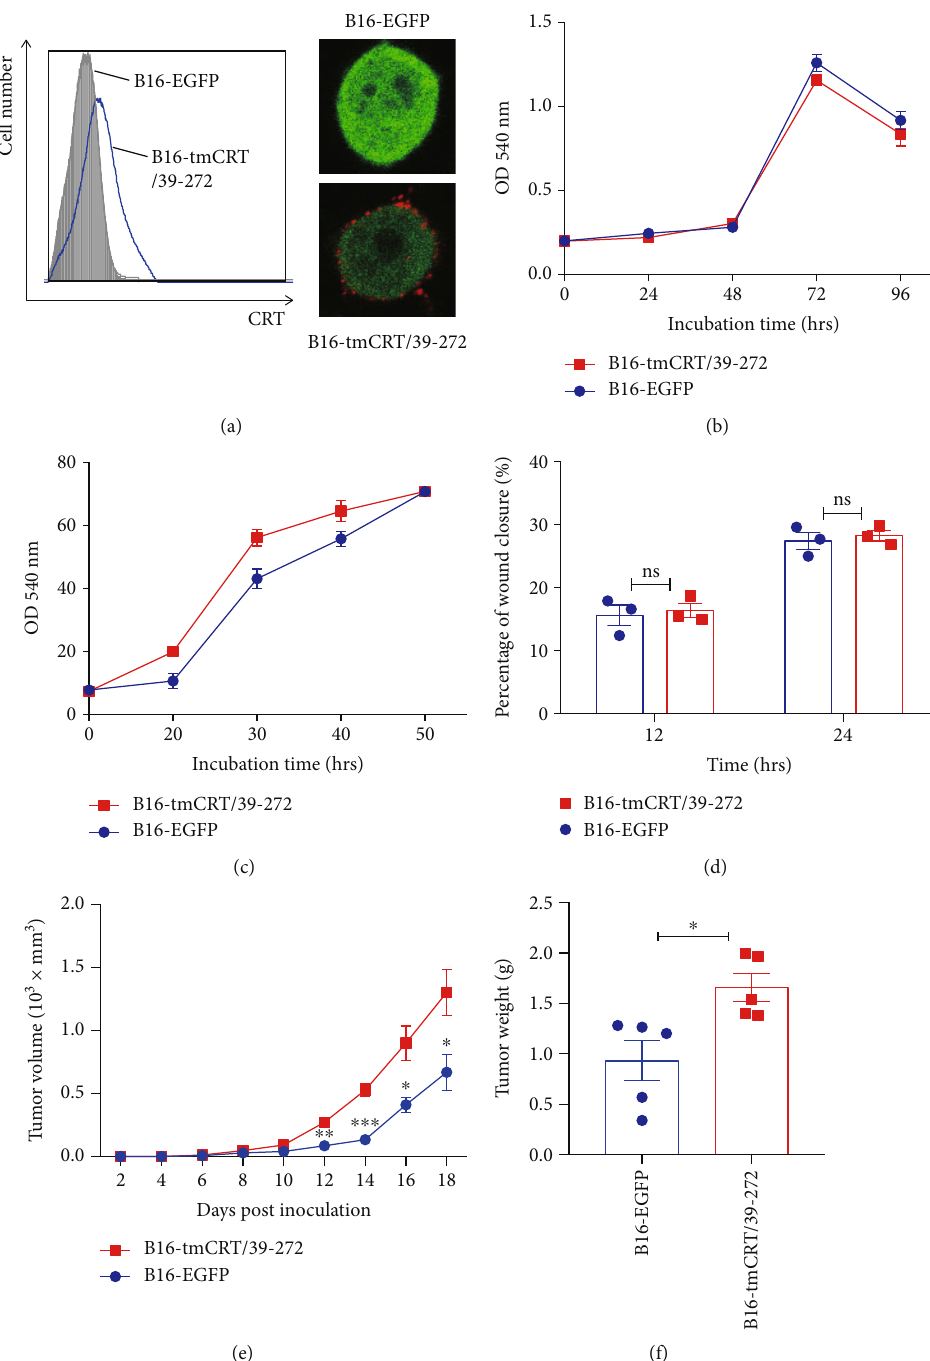
Figure 1: Construction and characterization of the B16-EGFP and B16-tmCRT/39-272 cell lines. (a) Surface expression of CRT on B16- EGFP and B16-tmCRT/39-272 cells were examined by FACS and confocal laser scanning microscopy. (b) MTT assay of B16-EGFP and B16-tmCRT/39-272 cell proliferation. (c) Cell adhesion assay of B16-EGFP and B16-tmCRT/39-272 cells post-scratch. (d) Wound healing assay for examining B16-EGFP and B16-tmCRT/39-272 cell migration. The width of the wound was measured 12h and 24h after wounding. (e and f) Female C57BL/6 mice ( n = 5 per group) were s.c. injected with B16-EGFP or B16-tmCRT/39-272 cells ( 5 × 105/100 μ l/mouse). The diameter of solid tumors at the injection sites was evaluated every 2 days thereafter for 18 days. (e) Tumor growth curves. (f) Tumor weights. The experiments were repeated three times. ∗ P < 0 : 05 , ∗∗ P < 0.01, ∗∗∗ P < 0 : 001 , ns: not signi fi